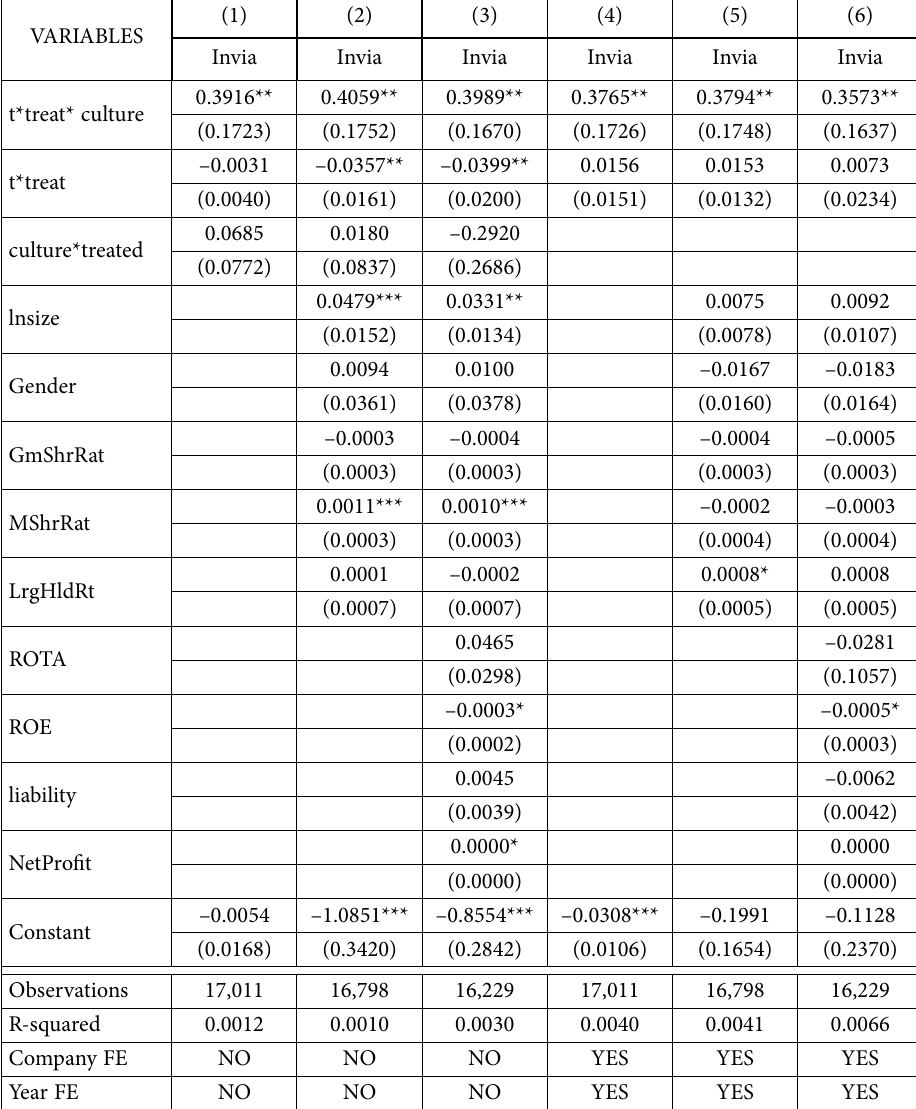
Table 3. Baseline regression